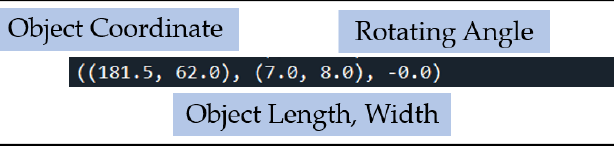
Figure 27. Information of the square.